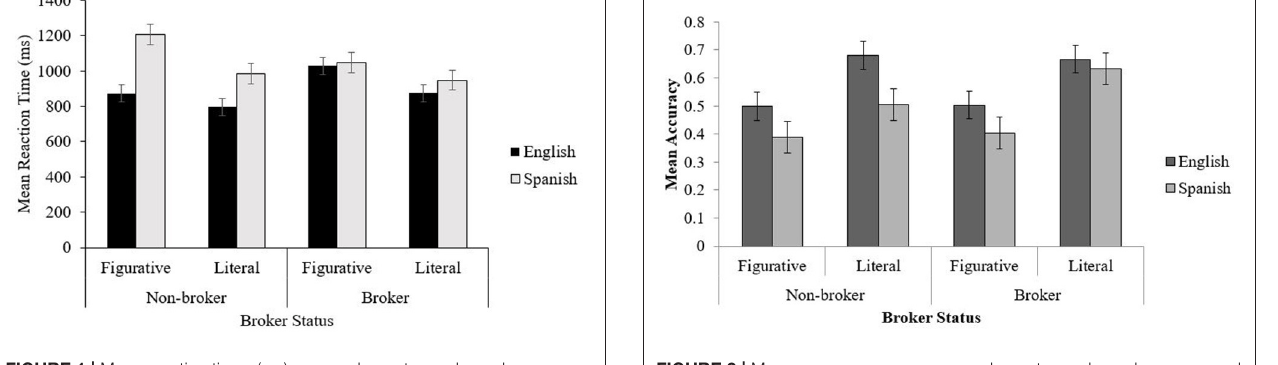
FIGURE 2 | Mean accuracy scores across phrase type, phrase language, and group. Error bars represent standard error of